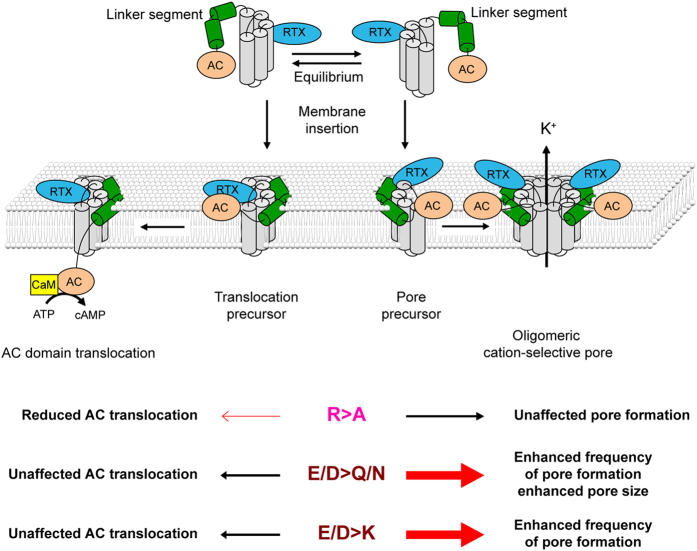
Schematic model of CyaA action on target membrane.CyaA penetrates the cytoplasmic membrane and would employ two distinct conformers to accomplish its multiple actions within the membrane. One conformer would form cation-selective pores that permeabilize the membrane bilayer for efflux of cytosolic potassium ions. The other conformer would translocate the AC enzyme domain into cells across the plasma membrane and catalyze conversion of cytosolic ATP to cAMP. As shown here, the ‘AC to Hly-linking segment’ can insert into the cell membrane and would adopt an α-helical conformation with the axis of the helices being parallel to the plane of the lipid bilayer41. The linker segment containing the positively charged arginine residues would exhibit membrane interacting properties and would induce a local destabilization of the lipid bilayer. This would subsequently facilitate translocation of the AC domain across the lipid bilayer41. As shown here, CyaA mutants carrying arginine to alanine substitutions (R > A) in the central and C-terminal part of the linker segment bind the target membrane and form membrane pores with equal efficacy as intact CyaA (except for CyaAR474A), while their ability to translocate the AC domain across the membrane is reduced. Replacement of the negatively charged residues of blocks II and III (E/D > Q/N, E/D > K) yields “hyperhemolytic” CyaA variants. Membrane-inserted pore precursors of the CyaAE419Q−E432Q and CyaAD445N+D446N+E448Q mutants assemble with high frequency, thereby giving rise to the highly increased pore-forming activity. Moreover, the pore precursors of CyaAE419Q−E432Q and CyaAD445N+D446N+E448Q constructs exhibit not only an increased propensity to form membrane pores but also form pores with higher conductance states. The ability of these mutants to translocate the AC domain across the membrane of target cells, however, is not affected. The model and the sizes of individual domains of CyaA are not drawn to scale. RTX, calcium binding RTX domain, AC, invasive AC domain, K+, potassium efflux, CaM, calmodulin.